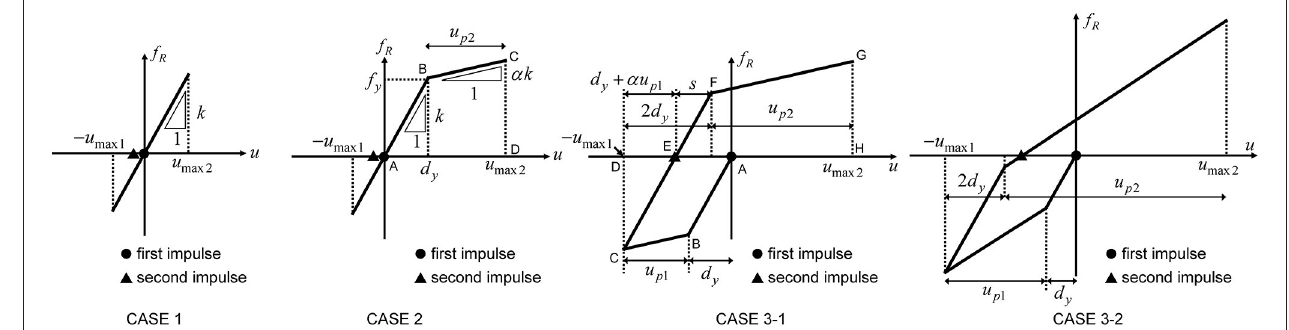
FIGURE 9 | Four cases of response process depending on input